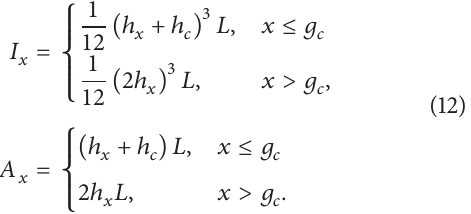
Figure 3: Geometrical parameters for the fillet-foundation deflec- tion